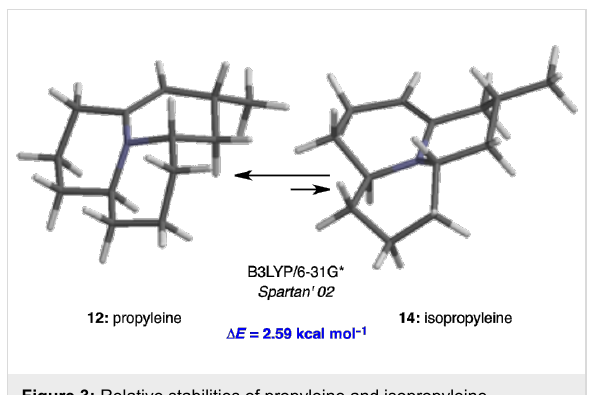
Figure 3: Relative stabilities of propyleine and